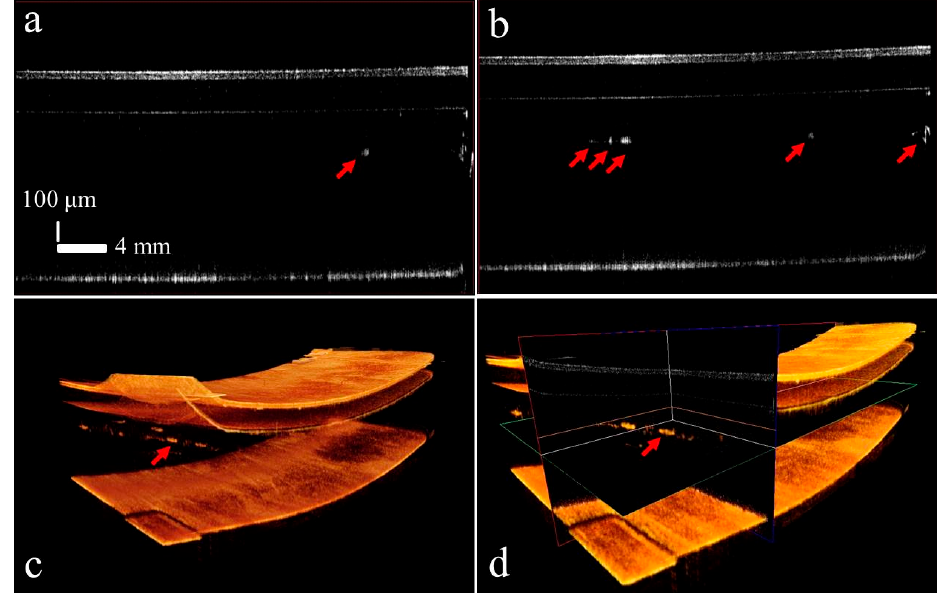
Figure 8. Results of sample head-2 of the SD-OCT-2 system with defects identified with red arrows: ( a ) cross-sectional view of single-point defect in the glass layer; ( b ) multiple defects in the glass layer; ( c ) 3D scan result showing multiple defects in the glass layer; ( d ) ortho-sliced view of defect.